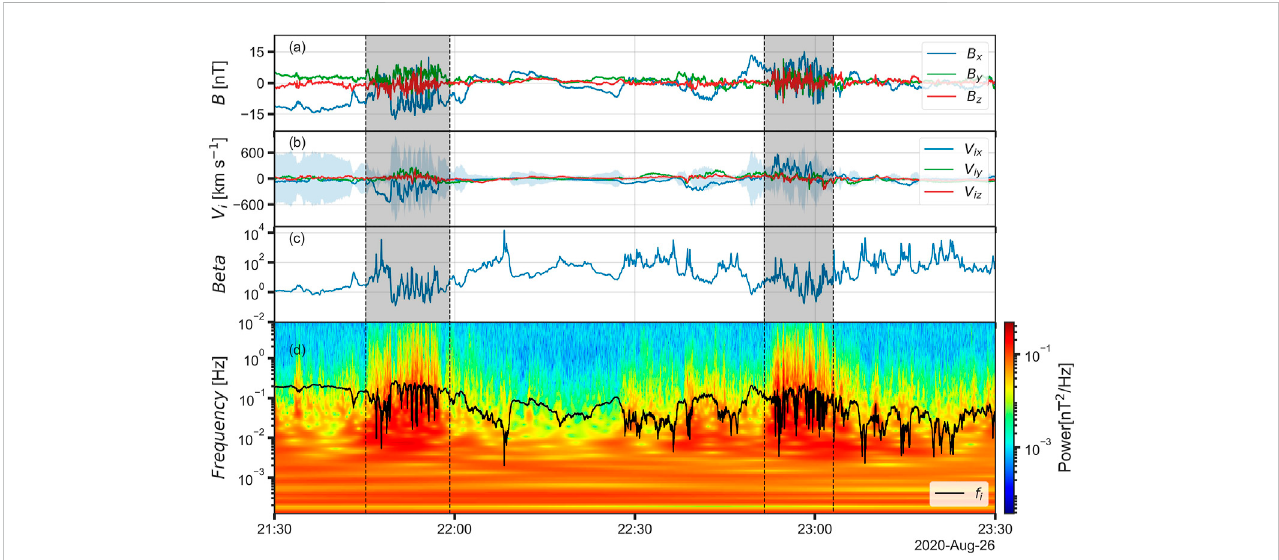
FIGURE 2 Flapping events 2020/08/26 (highlighted in gray) as observed by MMS. (A) Magnetic fi eld. (B) Plasma fl ow velocity. The shadow shows local Alfven velocity calculated from FPI and resampled FGM MMS data. Plasma bulk velocities do not exceed the Alfven velocity almost throughout all fl apping intervals. (C) β ion parameter. (D) Wavelet power spectrum of the magnetic fi eld vector. The black line indicates proton